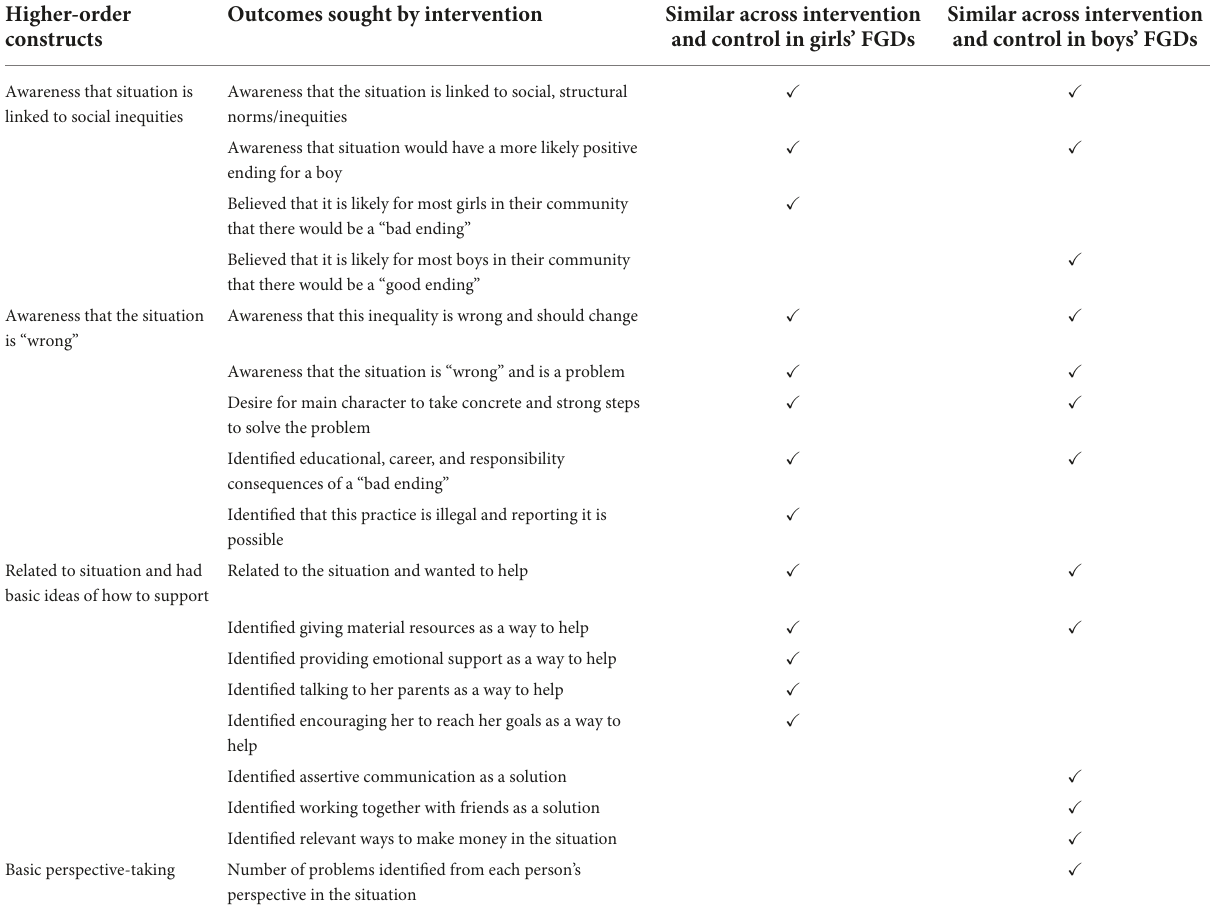
TABLE 5 Outcomes observed to be similar across the